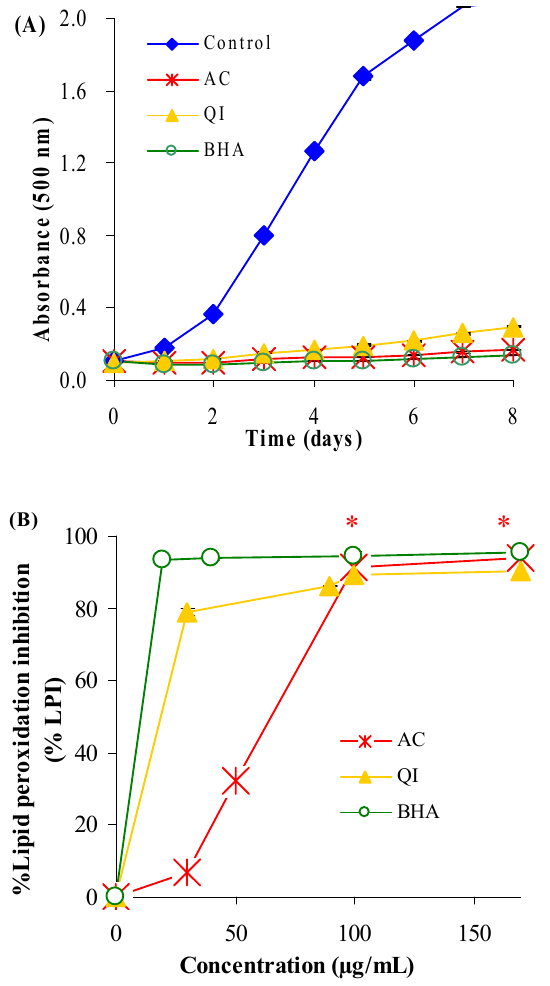
Figure 1. Effect of AC, QI and the positive reference (BHA) on lipid peroxidation of linoleic acid emulsion, as measured by formation of ferric thiocyanate. (A) Time course of linoleic acid peroxidation in the absence or presence of samples at 100 µg/mL concentration. (B) Percentage inhibition of lipid peroxidation as a function of sample concentration on day 8 of peroxidation. * No significantly different (p > 0.05) between percentage inhibition of BHA, AC and QI at concentration ≥ 100